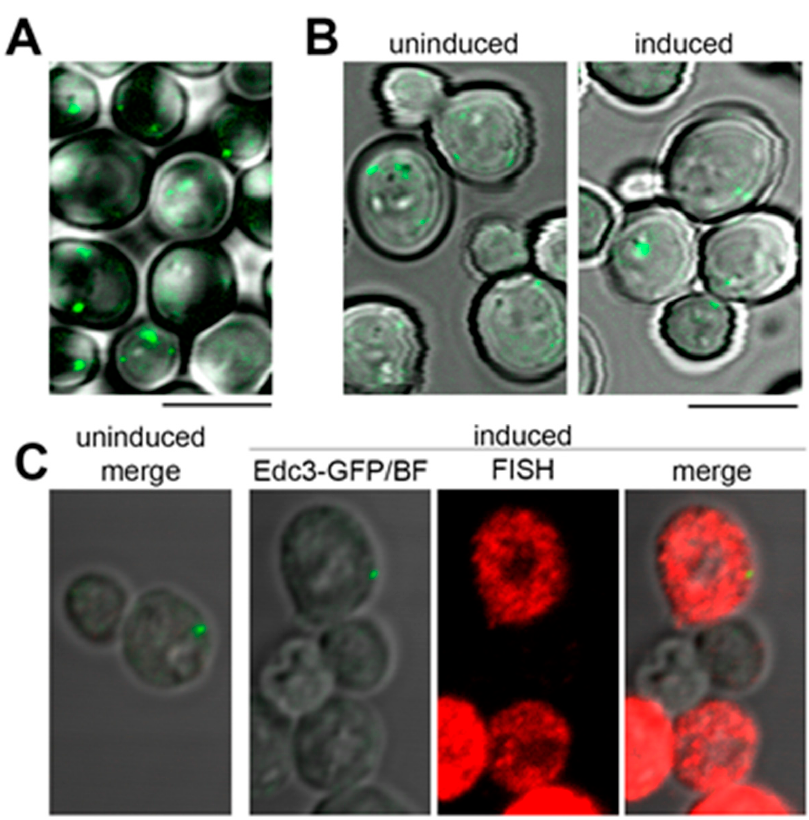
Figure 5. Expression of the model RNA does not induce formation of P bodies. ( A ): Live-cell imaging of nontransformed EDC3-GFP strain. Generally, under normal conditions, between one and three small P bodies per cell were detected. ( B ) and ( C ): The model RNA was expressed in EDC3-GFP strain as in Figure 2. Uninduced cells were used to control for P bodies unrelated to the expression of the model RNA and for unspecific FISH signal. ( B ): Live-cell imaging of EDC3-GFP strain. Expression of the model RNA leads to the increase in neither the size nor the number of P bodies per cell. ( C ): FISH-IF of the model RNA and Edc3-GFP showed that the granules of the model RNA are distinct from P bodies, although some of them may be located in the vicinity of each other. In ( A ) and ( B ), overlay of Edc3-GFP signal and bright field is shown. In ( C ), “FISH” corresponds to FISH detection of the model RNA, “Edc3-GFP / BF” corresponds to overlay of bright field and Edc3-GFP signal, and “merge” corresponds to overlay of bright field, FISH, and Edc3-GFP labeling. Scale bar is 5 µ m. As with the previous report [35], we found that Pub1 formed granular pattern in immunofluorescent labeling of wild-type cells. However, these granules did not generally colocalize with the granules of the model RNA, although some partial colocalization may have occurred (Figure 6, right panel). In cho2 ∆ , rpl42a ∆ , and rtc2 ∆ mutants, which accumulated the model RNA, the granular pattern of Pub1 was similar to that of the wild type, without obvious formation of distinct stress granules. As in the wild type, partial colocalization of Pub1 granules and the model RNA was observed. However, there was no more obvious extensive colocalization than in the wild type cells (Figure 6, right panel). Thus, our data do not support the idea that accumulation of the model RNA is linked to its targeting to the stress granules in the